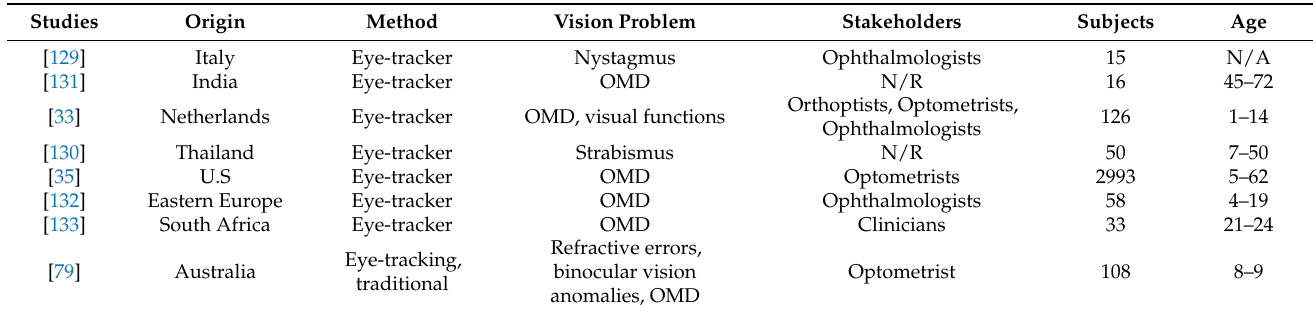
Table 4. Overview of the studies that used ET for vision screening. N/R = not reported.